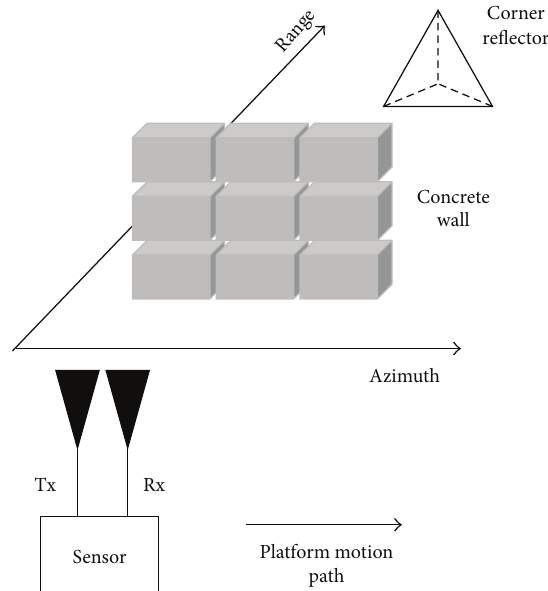
Figure 1: Schematic representation of the proposed experimental setup.